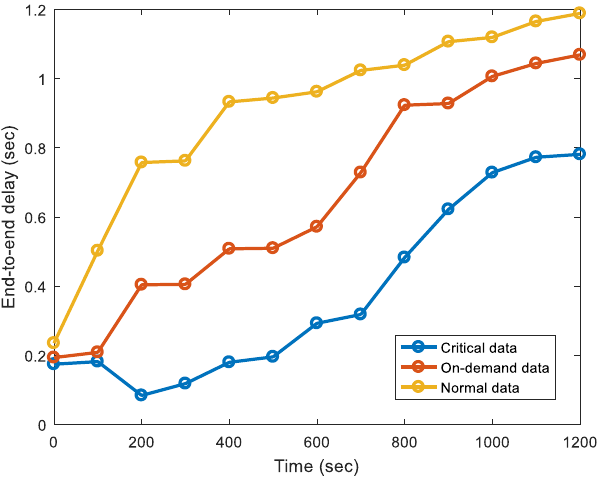
Figure 2. End-to-end